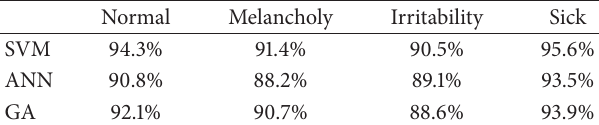
Table 4: The average detection accuracy comparison between the SVM MODEL and the other two